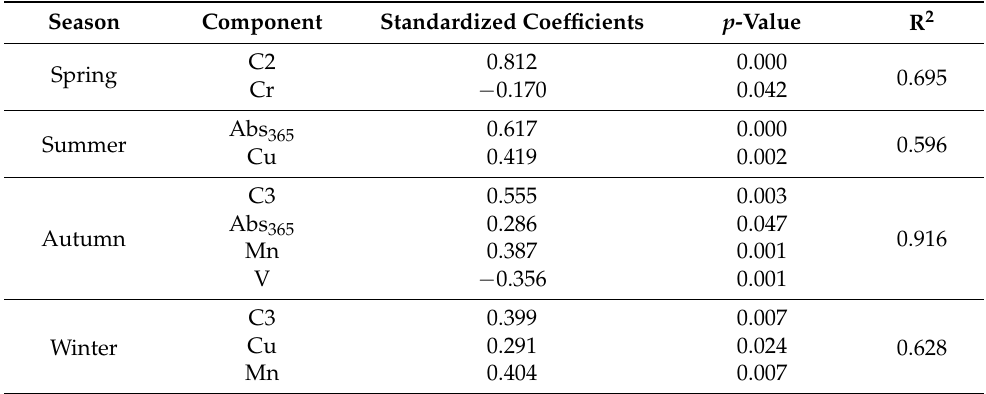
Table 1. Model of multiple linear regression output with DTT v as the dependent variable and organic target components and metals as independent